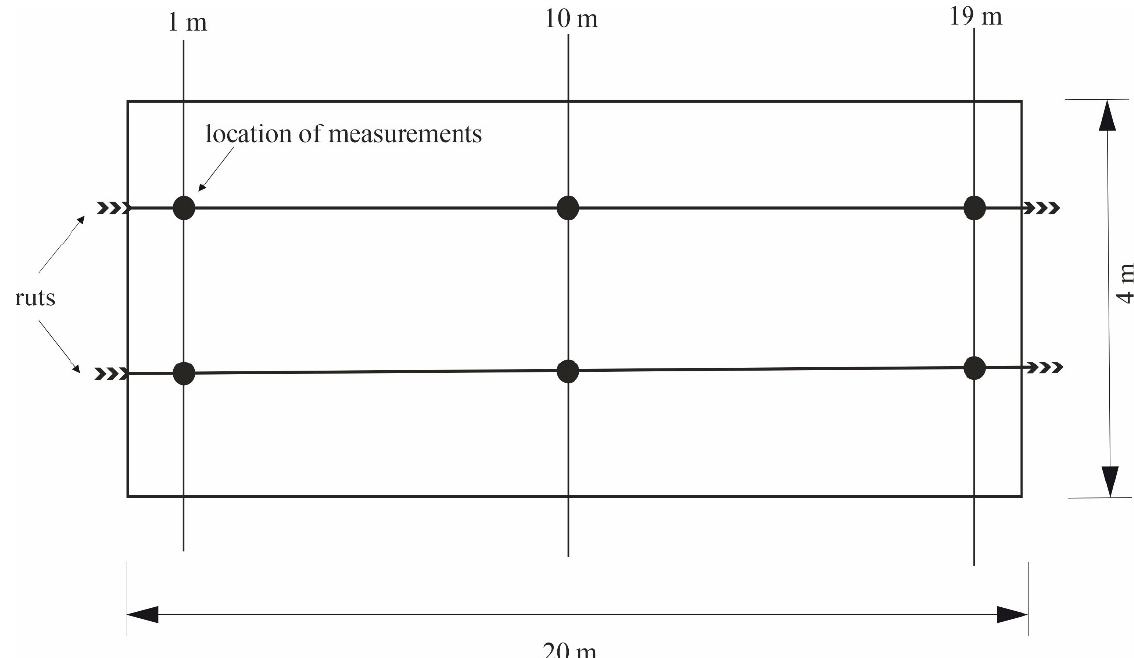
Figure 1 . The shape of study site and location of measurements. Figure 1. The shape of study site and location of measurements.